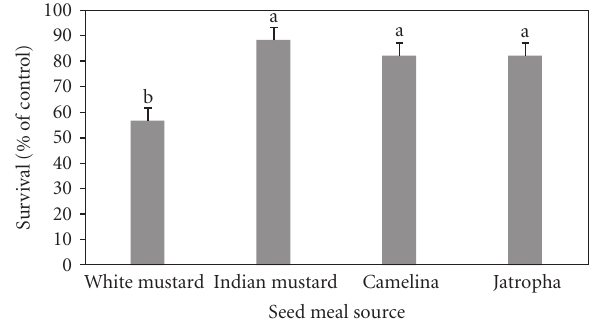
Figure 8: Main e ff ect of “seed meal source” on sorghum survival. Means followed by the same letter are not di ff erent at P < 0 . 05 by Fisher’s protected LSD. The e ff ect of “seed meal source” was not significant for sorghum emergence; therefore, the data is not shown. Data are means (four replications) ±